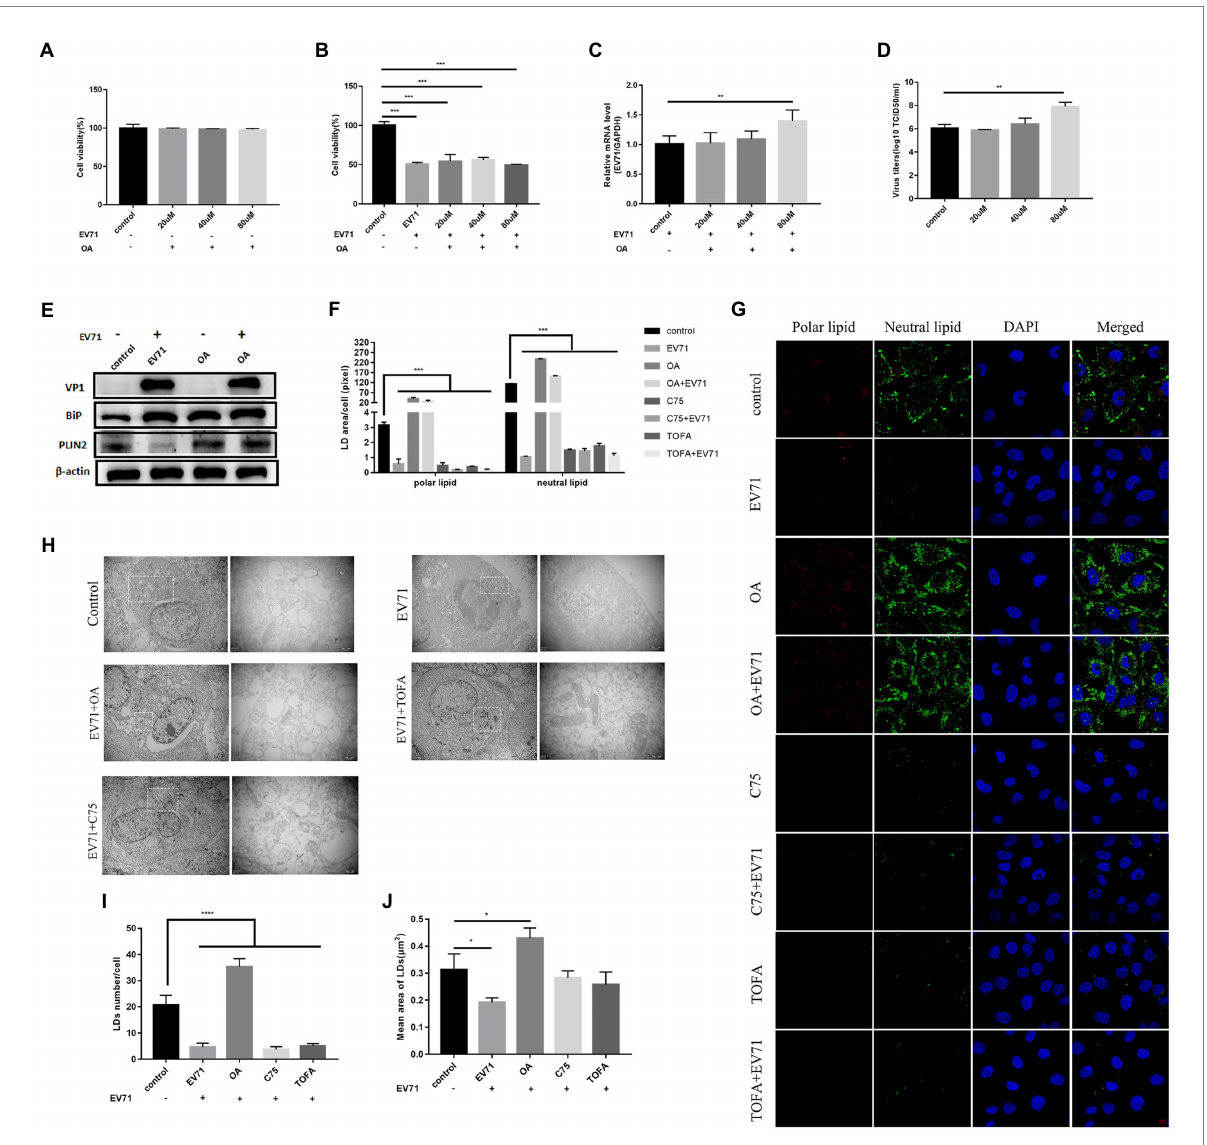
FIGURE 4 OA activates lipid metabolism and promotes EV-A71 replication. (A) After using20 μ M, 40 μ M, and 80 μ M OA to treat cells for 12 h, the cell viability was detected. (B)–(D) HUVECs were treated with 20 μ M, 40 μ M, and 80 μ M OA for 12 h and then incubated with EV-A71 for 12 h. (B) Cell viability was detected. (C) The expression levels of EV-A71 gene. (D) collecting the culture supernatant to detect the virus titer. The virus titers of the OA at 20 μ M, 40 μ M, and 80 μ M were 7.58 × 10 5 TCID50/ml and 2.13 × 10 6 TCID50/m. (E) Detection of VP1, BiP, and PLIN2 protein expression levels. Blank (1st channel), be infected with EV-A71 for 12 h (2nd channel), 80 μ M OA treated HUVECs for 12 h (3rd channel), and 80 μ M OA pretreated HUVECs for 12 h and then co-incubated with EV-A71 for 12 h (4th channel). (F) Quantitative calculation of the area of fluorescence in each cell. (G) Lipid droplets decreased after TOFA and C75 treatment, whereas lipid droplets increased after OA treatment. Nile Red staining was used to observe the expression levels of polar and neutral lipid droplets. Control (Cell culture 12 h), EV-A71(be infected with EV-A71 for 12 h), OA (80 μ M OA treated for 12 h), OA + EV-A71 (80 μ M OA pretreated for 12 h and incubated with EV-A71 for 12 h), TOFA (50 μ M TOFA treated for 12 h), TOFA+EV-A71 (50 μ M TOFA pretreated for 12 h and then incubated with EV-A71 for 12 h), C75 (50 μ M C75 treated for 12 h), C75 + EV-A71 (50 μ M C75 pretreated for 12 h and incubated with EV-A71 for 12 h). (H) The expression levels of lipid droplet was observed by TEM. Control (Cell culture 12 h), EV-A71 (be infected with EV-A71 for 12 h), OA + EV-A71 (80 μ M OA pretreatment for 12 h and then incubated with EV-A71 for 12 h), TOFA+EV-A71 (50 μ M TOFA pretreated for 12 h and then incubated with EV-A71 for 12 h), C75 + EV-A71 (50 μ M C75 pretreated for 12 h and incubated with EV-A71 for 12 h). (I) The number of lipid droplets per cell was quantitatively calculated. (J) The area of lipid droplets per cell was quantitatively calculated. All the experiments were carried out in triplicate. Error bars represent SEM. * means p < 0.05, ** means p < 0.01, *** means p <